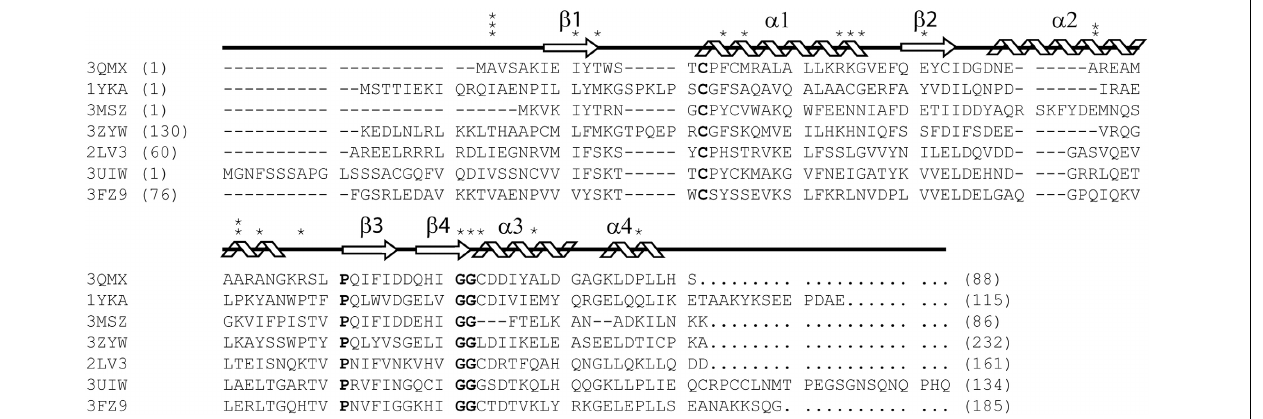
representation. Also shown as sticks, are the six histidine residues used for affinity purification. The amino (N) and carboxy (C) termini are